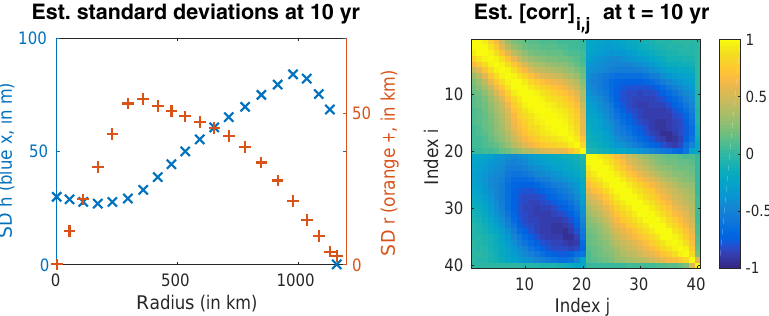
Figure 14. Standard deviations and correlation matrix Corr estimated from the analysis ensemble at time t = 10 years in the advanced configuration where we observe surface elevation. The matrix Corr has the same structure as B defined by Eq. (28). Both standard deviations and correlation structures are similar to Fig.